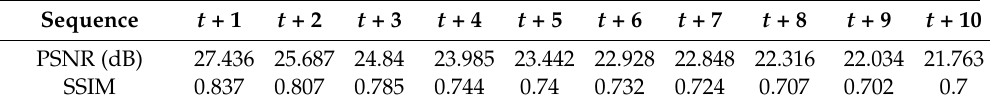
Table 3. PSNR (dB) and SSIM of the results in the test set.